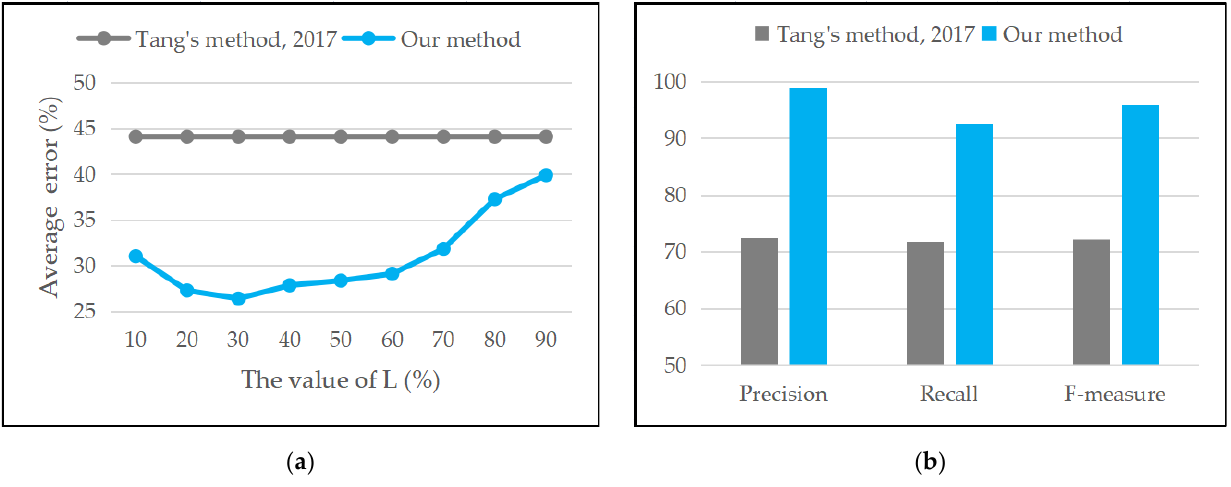
Figure 11. Performance comparison between Tang’s method [2] and our method of radius computing and center coordinate detection: ( a ) The average error of computing radius of intersections; ( b ) The accuracy of detecting center coordinate of intersections.